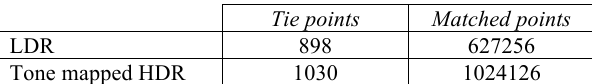
Table 7. Third metallic object (silver apple) matching results for different image